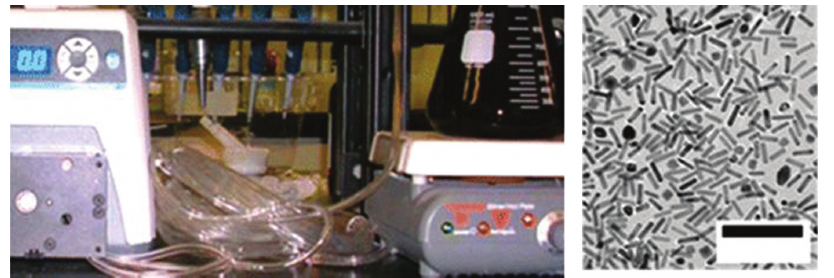
Figure 2 A simple millifluidic benchtop reactor system for the high-throughput synthesis and functionalization of gold nanoparticles with different sizes and shapes. Reprinted (adapted) with permission from [2]. Copyright (2013) American Chemical Society.